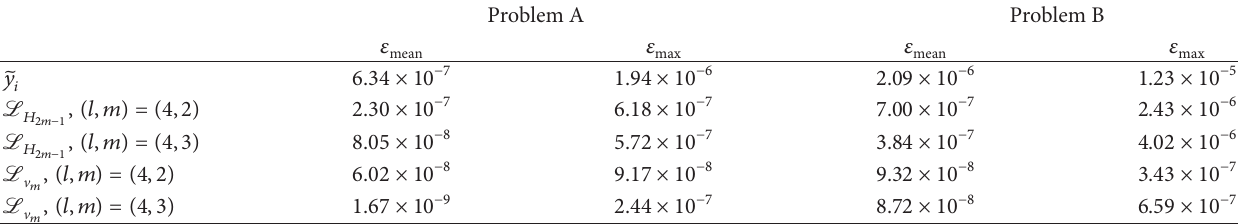
Table 5: Numerical results of the initial value Problems A and